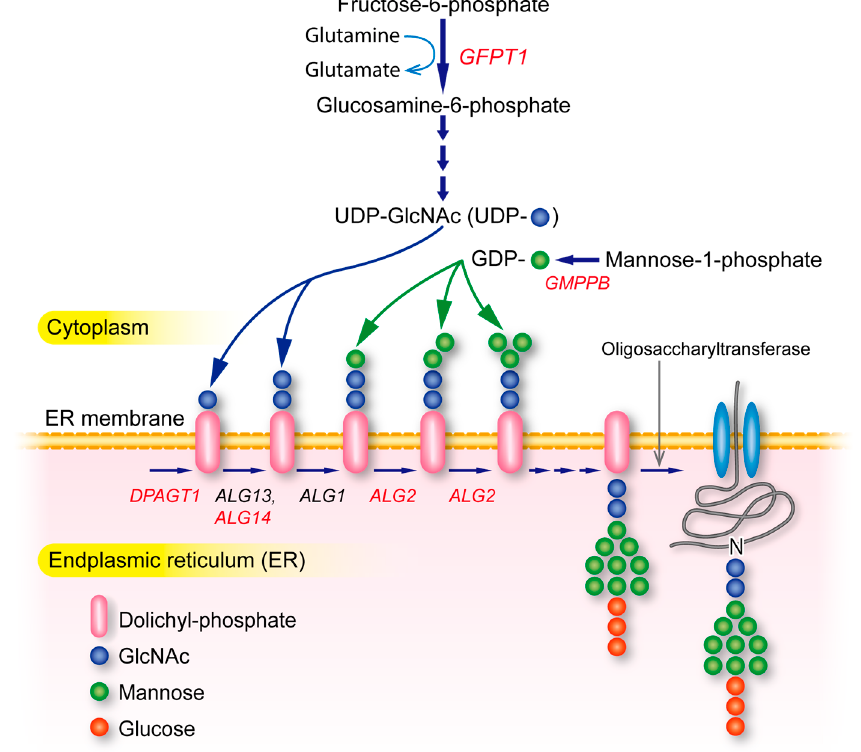
Figure 4. Hexosamine biosynthesis pathway to make UDP-GlcNAc and N-glycosylation pathway. Genes causing CMS are shown in red. Figure 4 is shown as an inset in Figure 1.